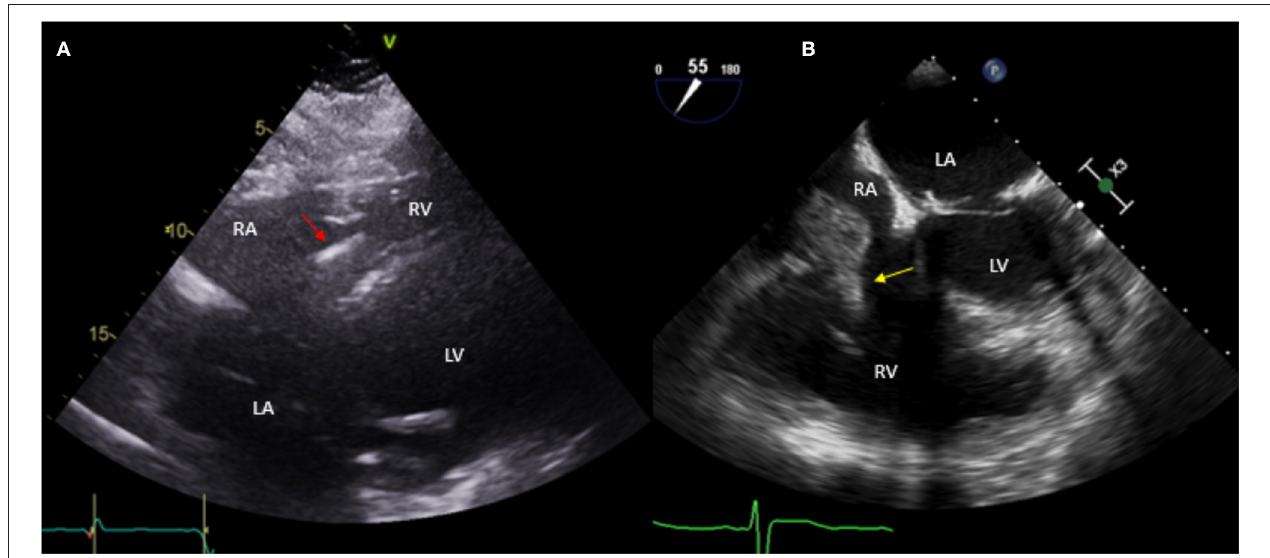
FIGURE 2 | Fifty nine year-old male with a historyof ischemic cardiomyopathy (EF 35%) s/p ICD for primary prevention of sudden cardiac death who presented with fever and MSSE bacteremia. Initial TTE done (A) shows subcostal view with ICD lead in place (red arrow), without evident vegetations. Based on high clinical suspicion for CIED infection, a TEE was obtained (B) which showed a large vegetation attached to the ICD lead prolapsing into the right ventricle (yellow arrow). The patient was treated with IV antibiotics but given persistent bacteremia and large vegetation he underwent sternotomy with ICD system extraction and epicardial defibrillator